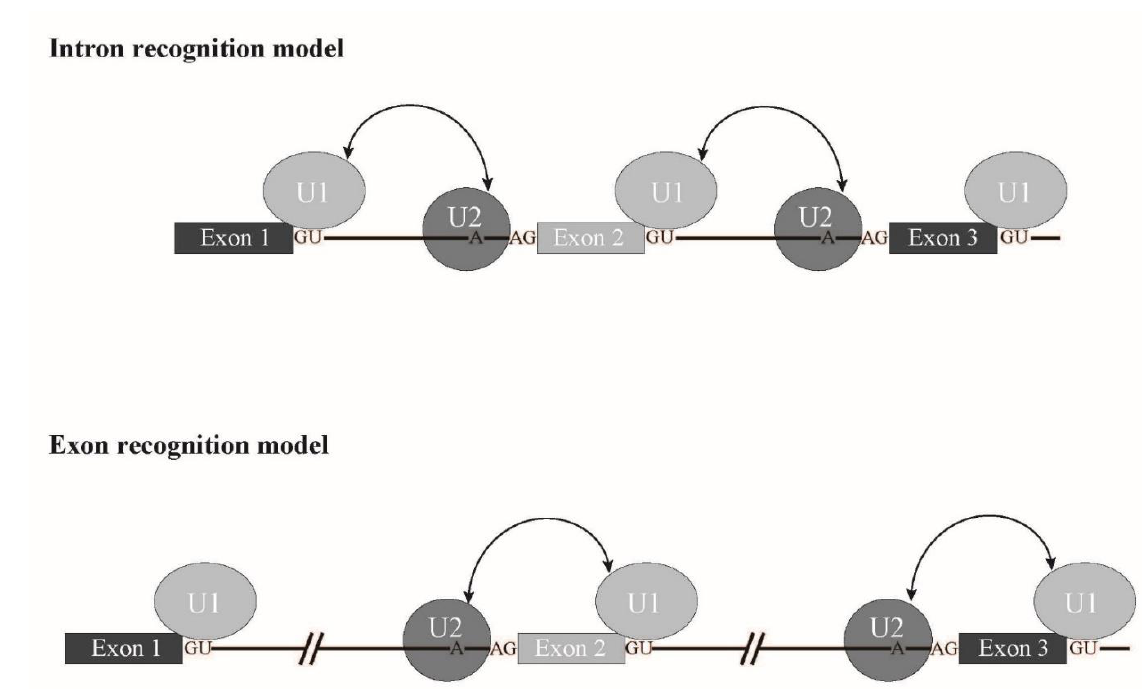
Figure 6. Schematic representation of exon recognition and intron recognition models during splicing. In lower eukaryotes, whose intron size is small, intron recognition is a dominant mode for splicing (upper panel). Introns are recognized by crosstalk between U1 snRNP and U2 snRNP that bind to the 5′ splice site and a branch point, respectively. On the other hand, exon recognition is major for splicing in vertebrates, in which introns are long. In this type, exons are recognized via interaction over exons between U2 snRNP and U1 snRNP that bind to a branch point and the 5′ splice site, respectively (lower panel).